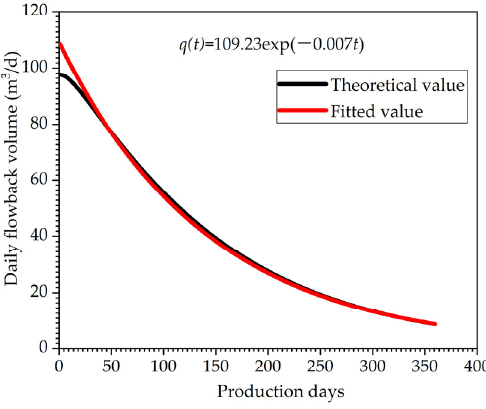
Figure 2. Theoretical flowback curve for multistage fracturing of horizontal wells.